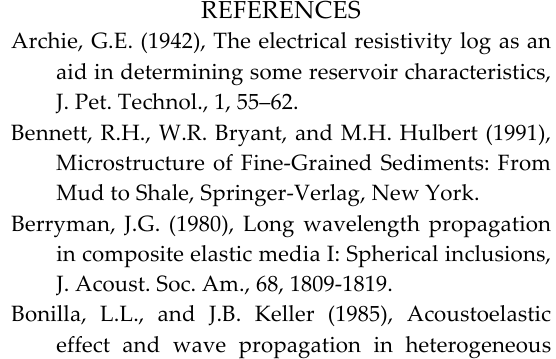
dark black line in figure